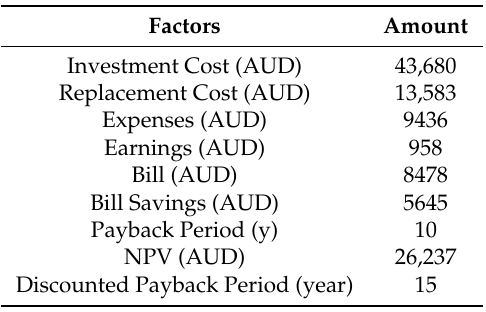
Table 8. Overall cost-benefit analysis of the